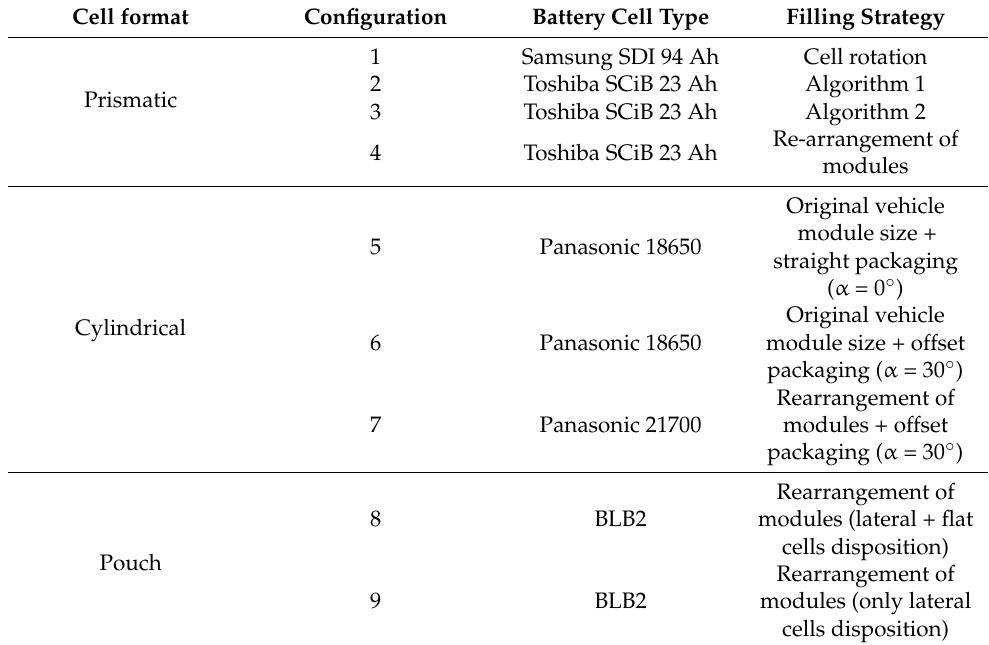
Table 3. Strategies for cell and module disposition in the specific battery pack configurations with prismatic, cylindrical and pouch-cell formats.